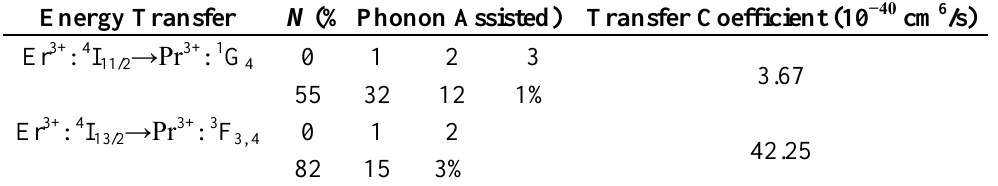
Table 3. Energy transfer microscopic parameter of Er 3+ and Pr 3+ in germanate